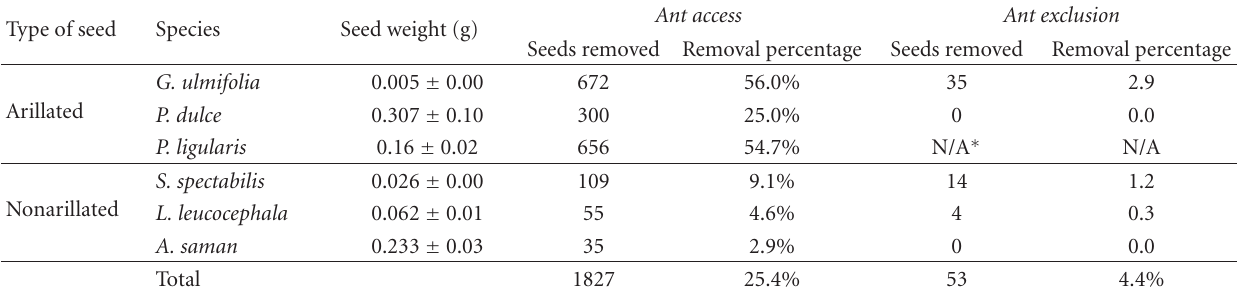
Table 2: Mean seed removal of nonmyrmecochorous seeds by ants in cattle grasslands. Standard errors are shown for seed weights.